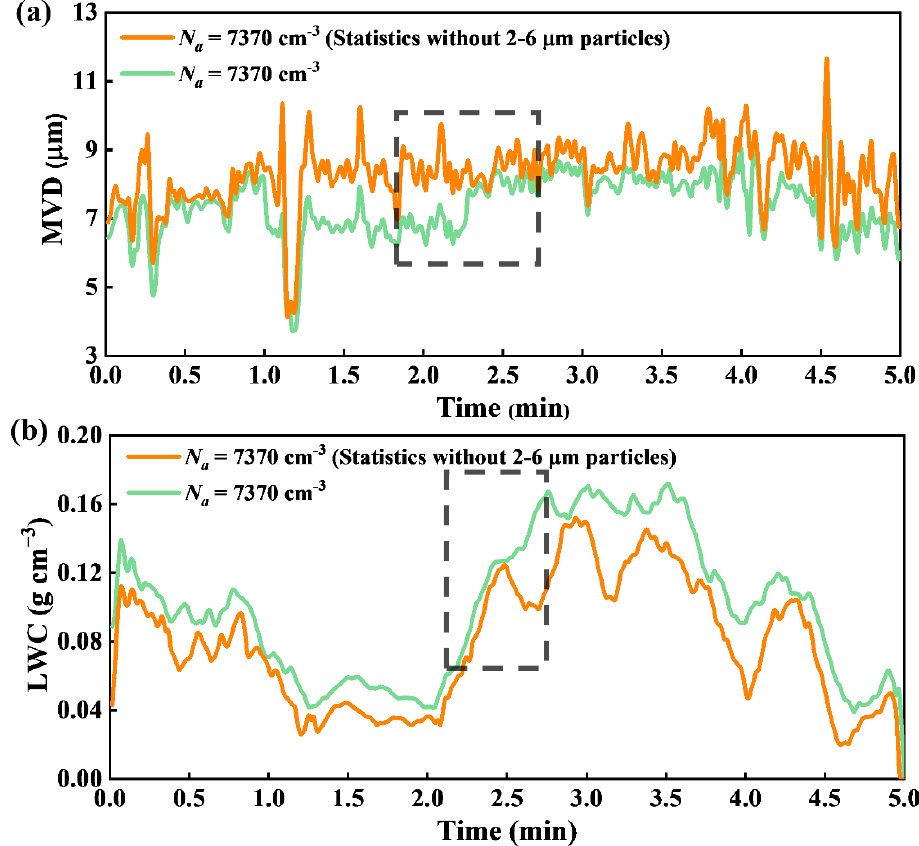
Figure 12. The changes in microphysical parameters at Na = 7370 cm −3 . ( a ) The original MVD and the MVD without 2 –6 μm droplets. ( b ) The original LWC and the LWC without 2 –6 μm